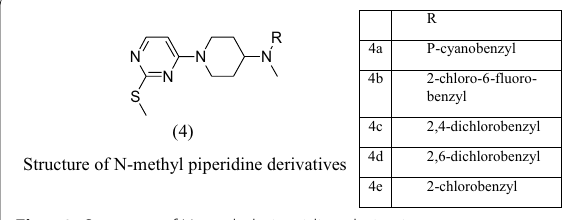
Fig. 9 Structure of N‑methyl‑4‑piperidone derivative